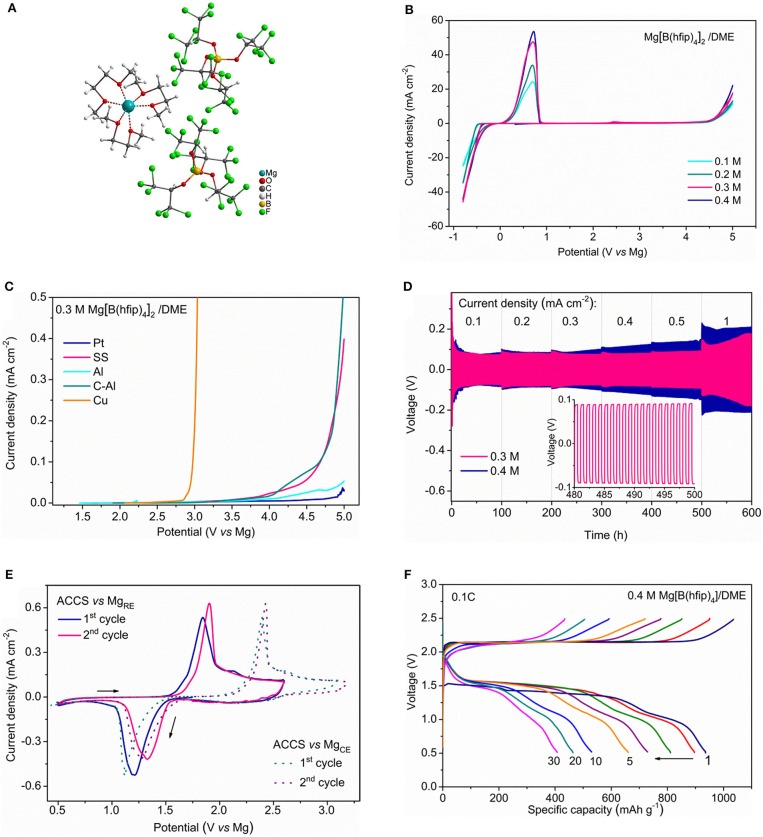
(A) X-ray crystal structure the Mg [B(hfip)4]2·3DME; Reprinted from reference (Zhao-Karger et al., 2017) with permission from the Royal Society of Chemistry. (B) Cyclic voltammograms on Pt electrode at a scan rate of 25 mV s−1. (C) Linear sweep voltammograms on various electrodes at a scan rate of 1 mV s−1. (D) Mg cycling performance of Mg[B(hfip)4]2/DME electrolytes in symmetric Mg|Mg cells at different current rates. (E) Cyclic voltammograms of the ACC-S electrode using Mg as both counter and reference electrodes. (F) Discharge/charge profiles of the Mg-ACCS cells in Mg[B(hfip)4]2/DME electrolyte at 0.1 C. Reprinted with permission from reference (Zhao-Karger et al., 2018) Copyright (2018) American Chemical Society.